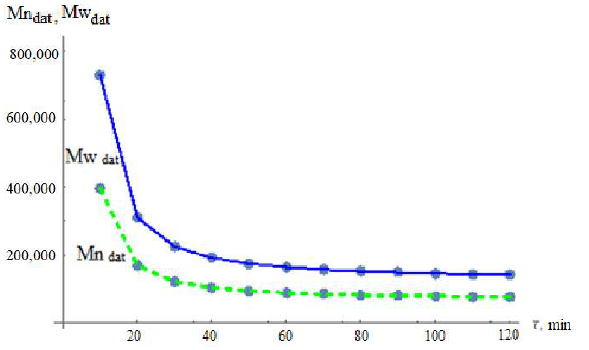
Figure 2. Dependence of the average number Mn dat and average mass Mw dat molecular weights of the fraction of diblock polypropylene chains starting their growth on the 2nd type of AC on the residence time in the reactor (calculated with the basic values of the model parameters).